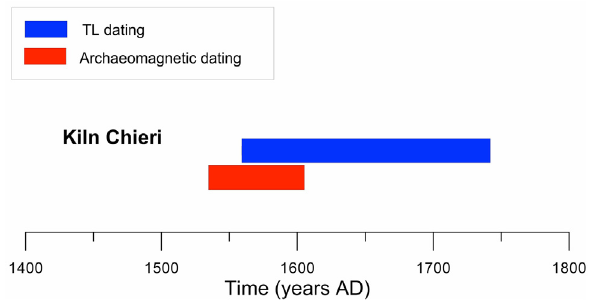
Figure 9. Archaeomagnetic and thermoluminescence dating results of the kiln excavated at